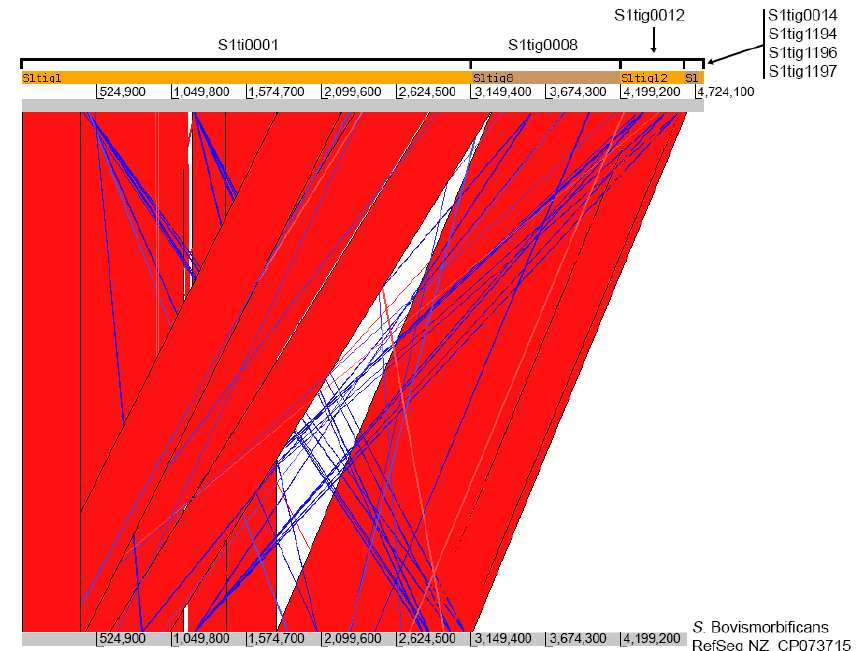
Figure 2. Comparison of the sequences from setting S1 against the reference genome. The contigs are detailed above the query line. Red and blue lines indicate forward and reverse matches, respec- tively.